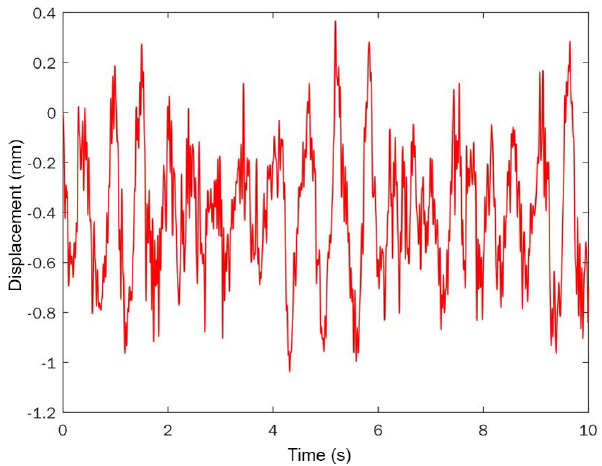
Figure 14. Vibration frequencies vs. distance L between the satel- lite and rocket.